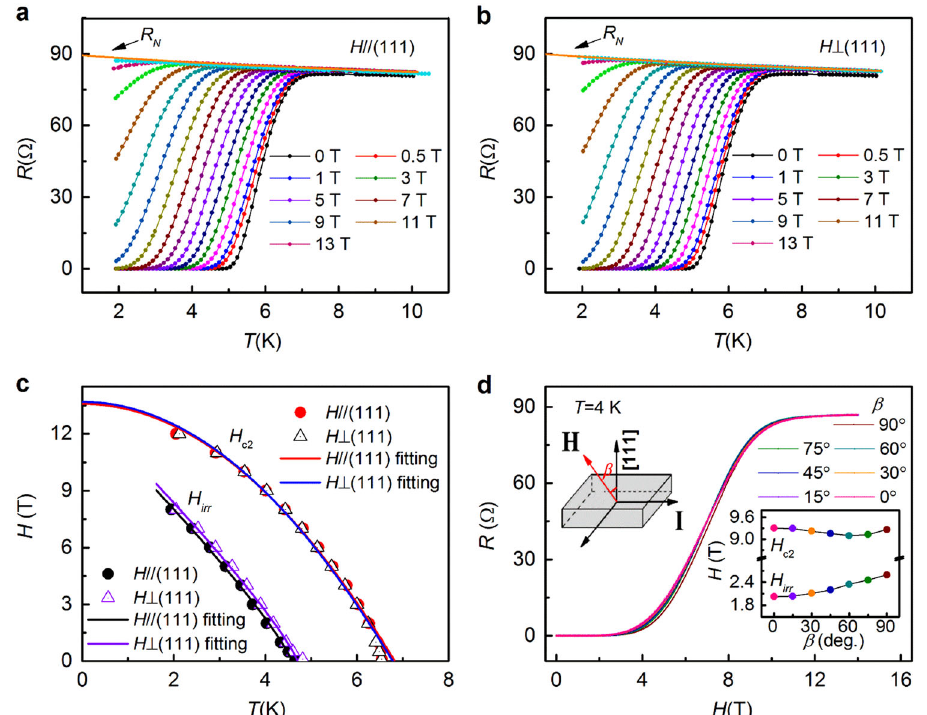
Fig. 4 Upper critical fi eld and irreversibility fi eld . a , b Temperature-dependent resistances in different magnetic fi elds a parallel ( H //(111)) and b perpendicular ( H ⊥ (111)) to the TiO fi lm surface. c Temperature-dependent H c2 and H irr in different magnetic fi eld directions H ⊥ (111) and H // (111). The hollow triangles and solid dots are experimental results deduced from ( a ) and ( b ), and the lines are the fi tting results . d Magnetic fi eld dependencies of the resistances at 4.0 K with different angles β (de fi ned as the inset). The inset shows magnetic fi eld angle dependences of H irr and H c2